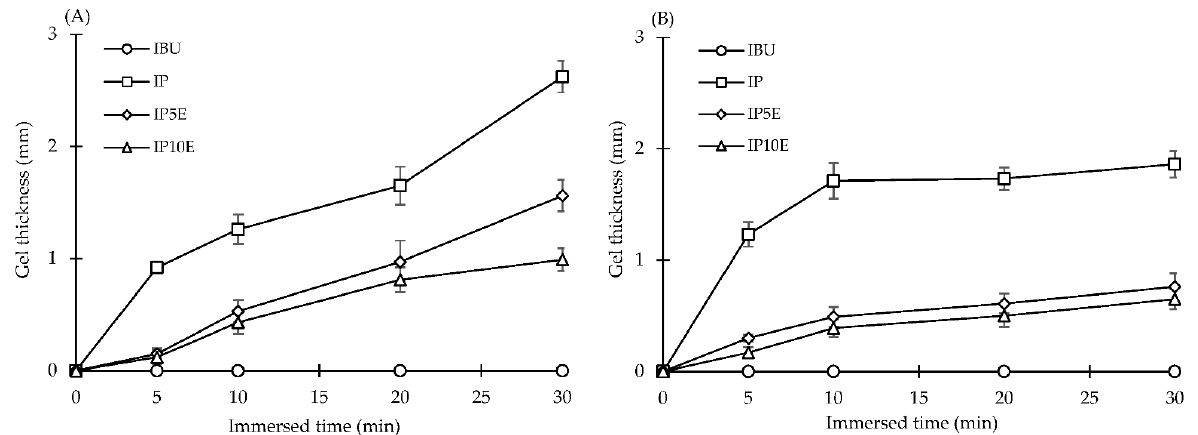
Figure 4. The gel formation capacity of eutectic effervescent tablets in distilled water ( A ) and 0.1 N HCl buffer pH 1.2 ( B ).